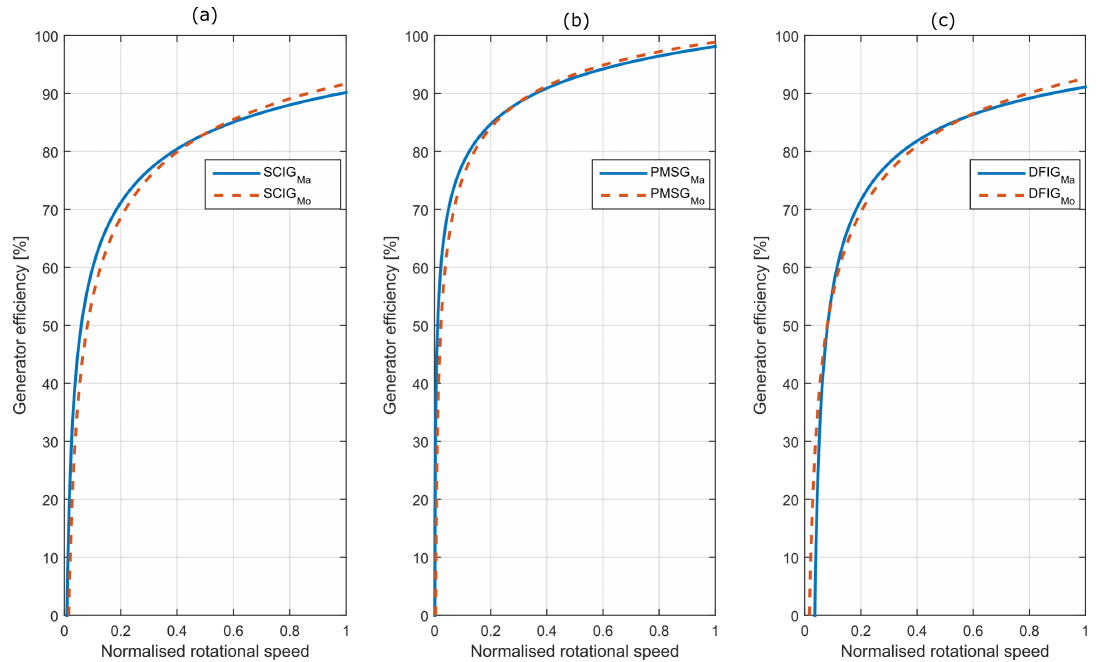
Figure 15. Efficiency of the SCIG ( a ); PMSG ( b ) and DFIG ( c ) for the Test 1c test case.